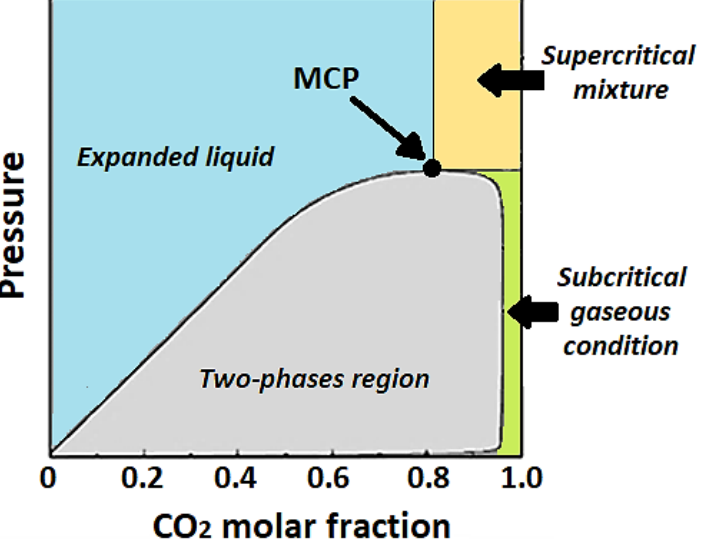
Figure 2. Sketch of vapor–liquid phase equilibria (VLEs) of a type I binary system.